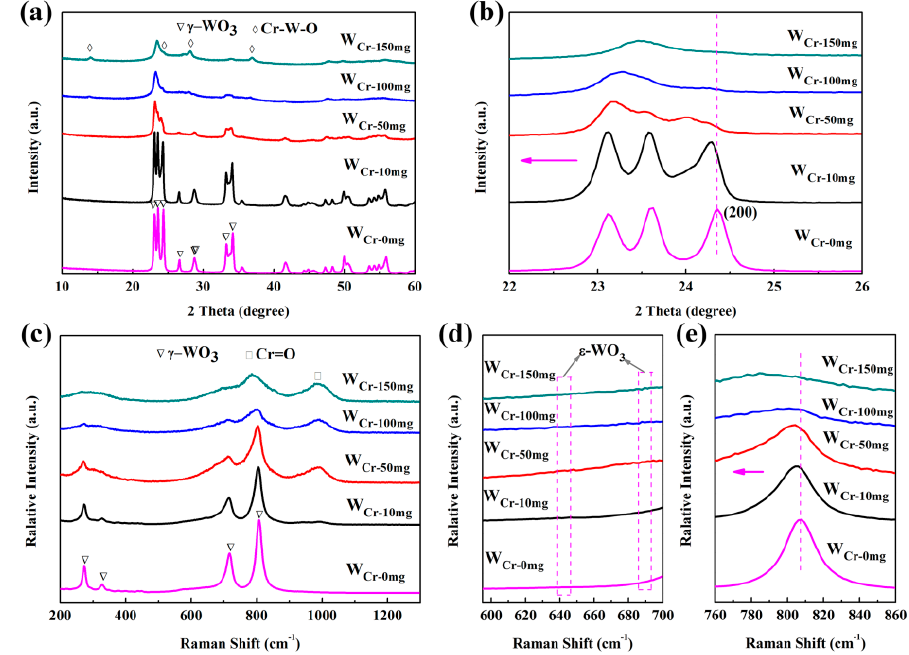
Figure 3. ( a , b ) X-ray powder diffraction (XRD) patterns, (c–e) Raman spectra of W Cr-0mg - W Cr-150mg .